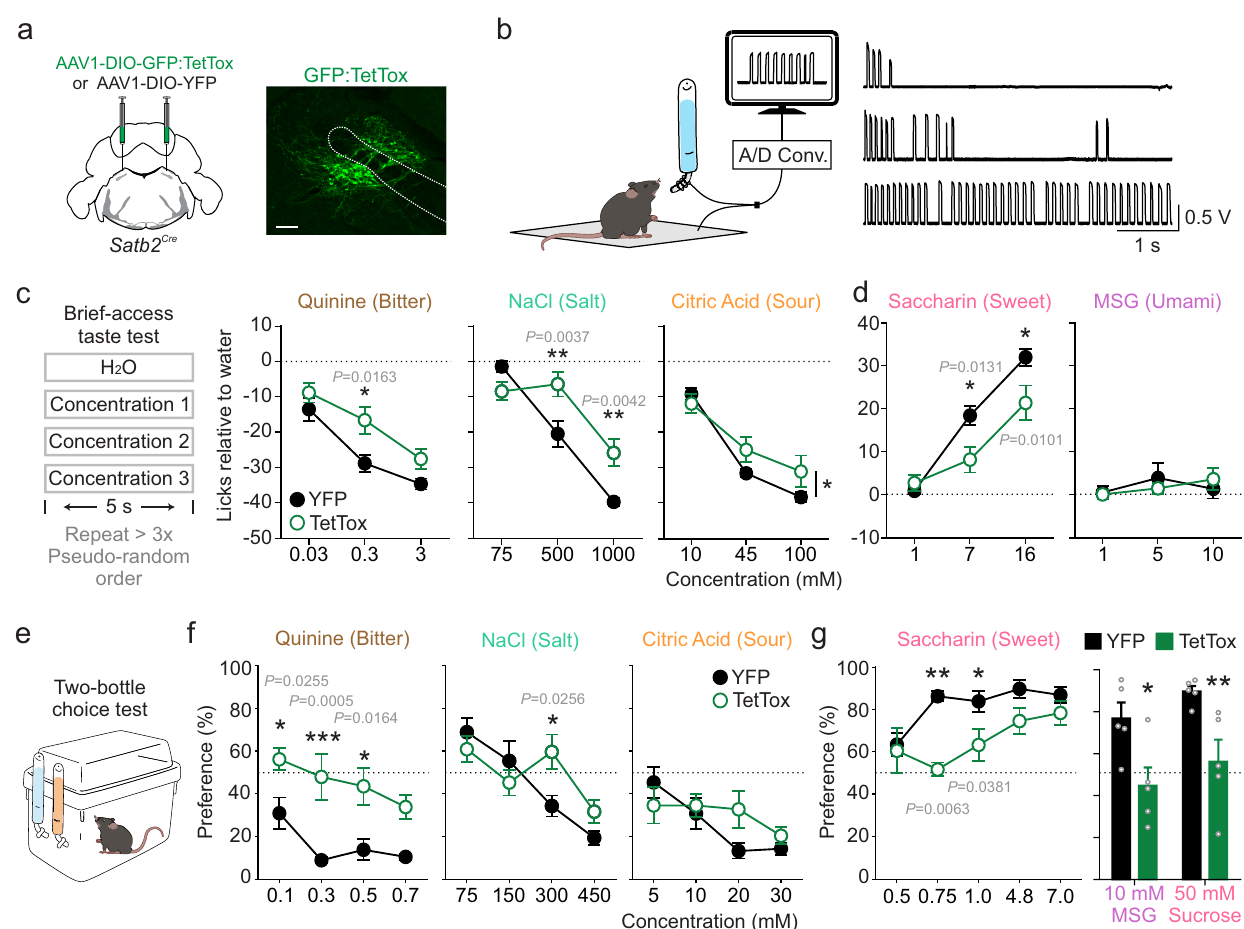
Fig. 3 Inactivation of Satb2 neurons attenuates innate taste preferences and aversions. a Satb2 Cre mice injected with AAV1-DIO-GFP:TetTox or AAV1- DIO-YFP and representative image of viral expression, similar levels of expression were veri fi ed in all TetTox mice used. Scale bar, 100 µ m. b Mice were water restricted and given brief access to water and three concentrations of a taste solution. Example recordings of licks for different concentrations of